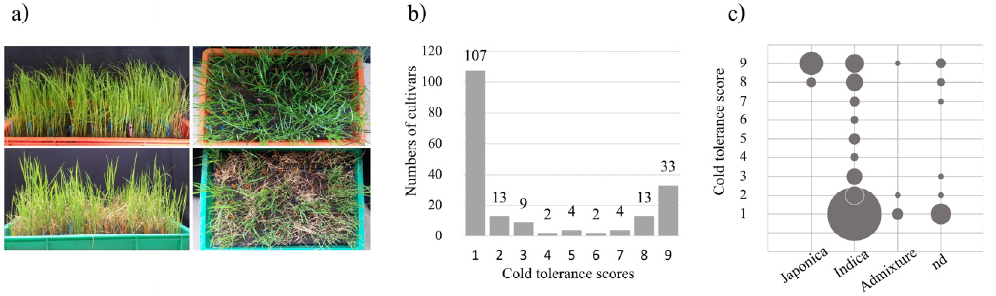
Figure 1. Phenotypic variation of rice accessions in response to cold treatment. ( a ) Top, 10-day old seedlings before cold treatment; bottom, 10-day old seedlings after cold treatment at 6 ± 2 °C for three days and recovery at 30 °C for 10 days . ( b ) Phenotypic variation of rice accessions in response to cold treatment, X-axis is cold tolerant score (1–9), Y-axis is number of rice accessions. ( c ) The cold tolerance score structure (Y-axis) in different subspecies (X-axis) .